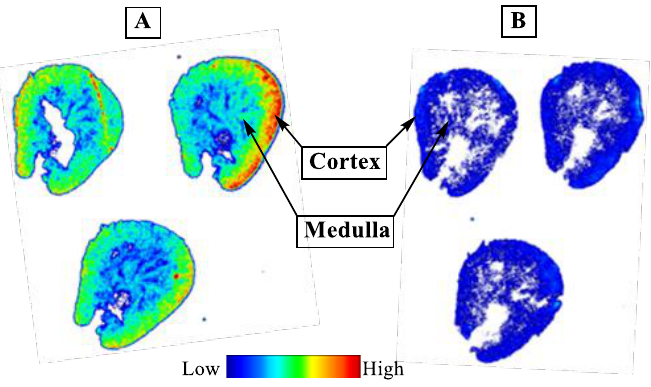
Figure 4. In vitro autoradiography of [ 18 F] 1 in transversal cryosections of the mouse kidney. Total ( A ) and non-specific ( B ) binding of ~1 nM [ 18 F] 1 obtained without and with co-incubation with 10 µM α -CCA-Na.